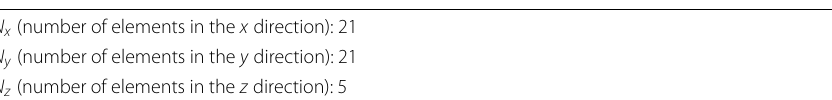
Fig. 15 Displacement using plate theory ( a ), all plate theory elements except the patch super-element ( b ), all patches as depicted in Fig. 16 ( c ), fully 3D refined FEM ( d ) Table 5 Coarse 3D